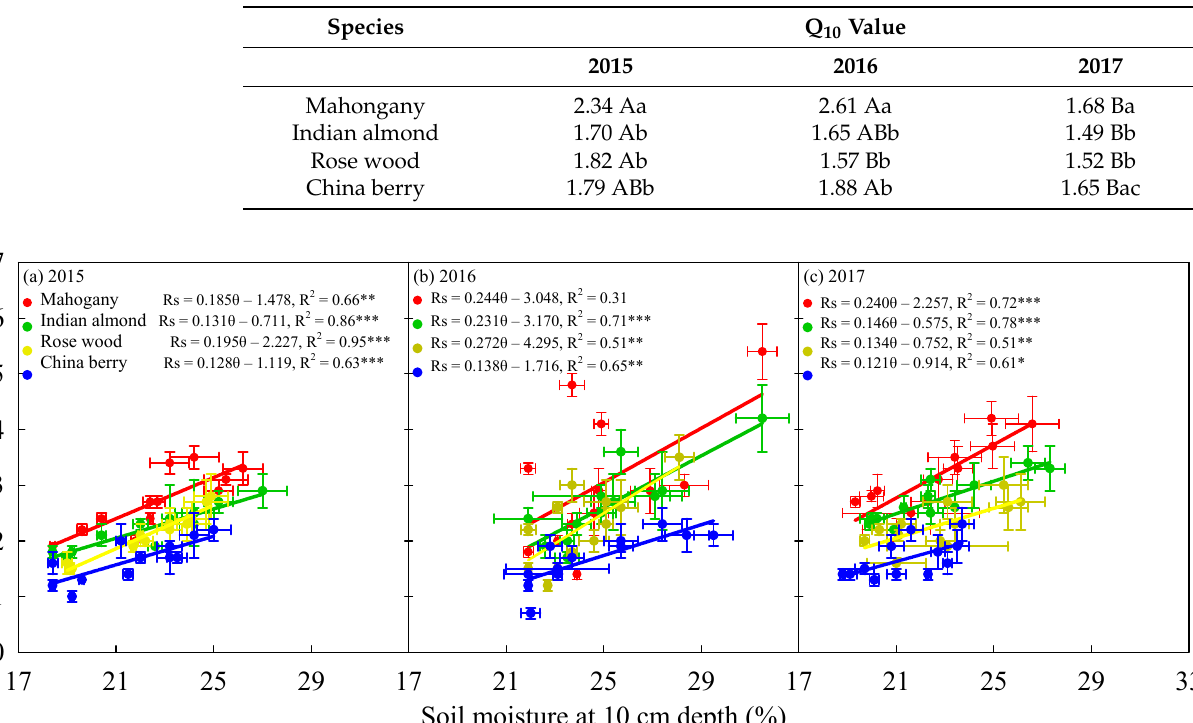
Figure 5. Relationships between monthly mean soil respiration (Rs, µ mol CO 2 m − 2 s − 1 ) and volumetric soil moisture at a 10 cm depth (%) for studied tree species in ( a ) 2015, ( b ) 2016, and ( c ) 2017. Asterisks indicate a significance: * p < 0.05, ** p ≤ 0.01, *** p < 0.001. Values are presented as the mean ± standard errors, n = 4.